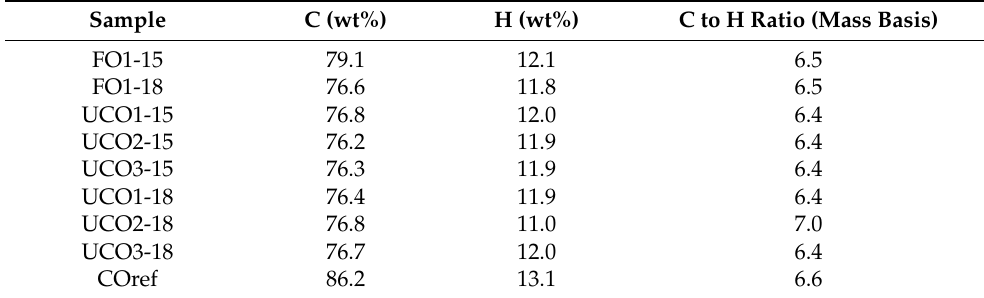
Table 3. H and C contents and mass ratios of the bio-oils and a commercial product analyzed with CHNS-O elemental analyzer. The overall average standard deviation is 0.4.